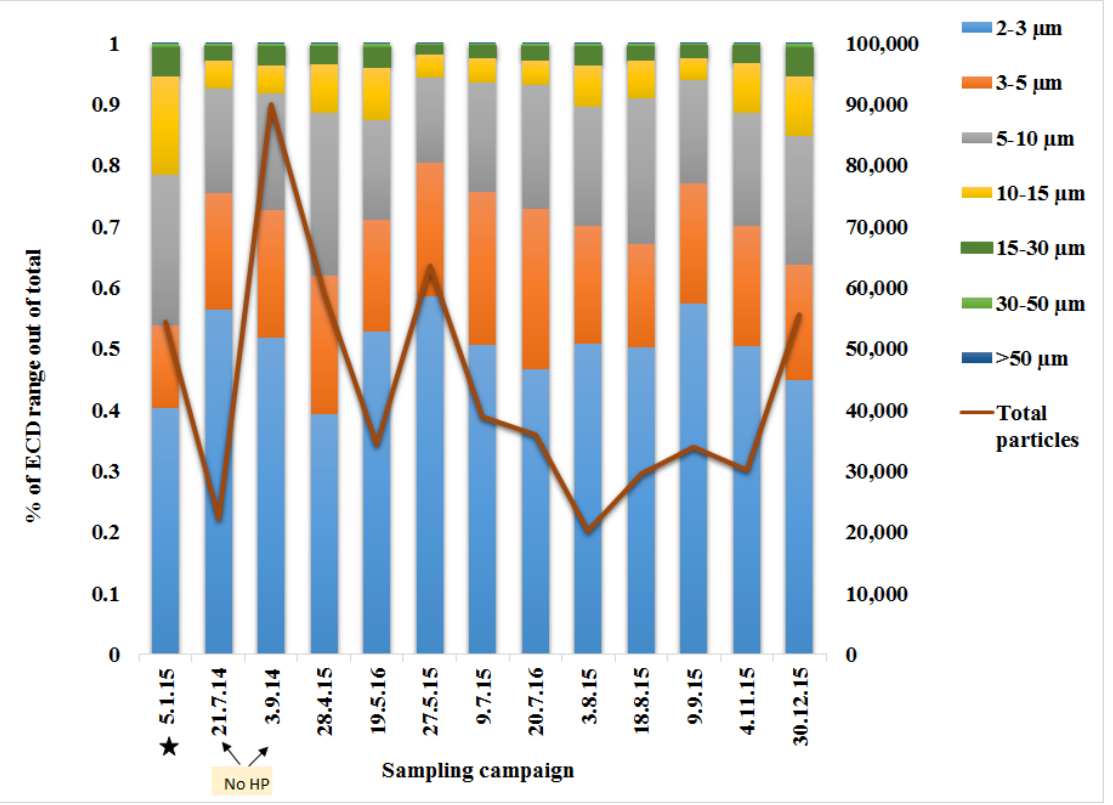
Figure A1. Particle distribution analysis over sampling campaigns. The Particle size is represented as an equivalent circular diameter (ECD). Total particle concentration (#/mL) is plotted as a red line. The results presented at Figure 2 refer to the campaign marked with a star. No HP is related to control runs without the addition of H 2 O 2 .